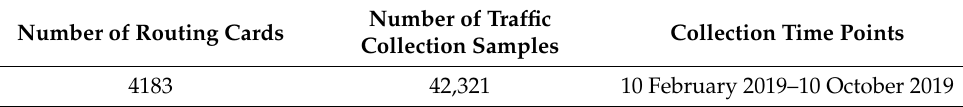
Table 1. Statistics for the dataset. Number of Routing Cards